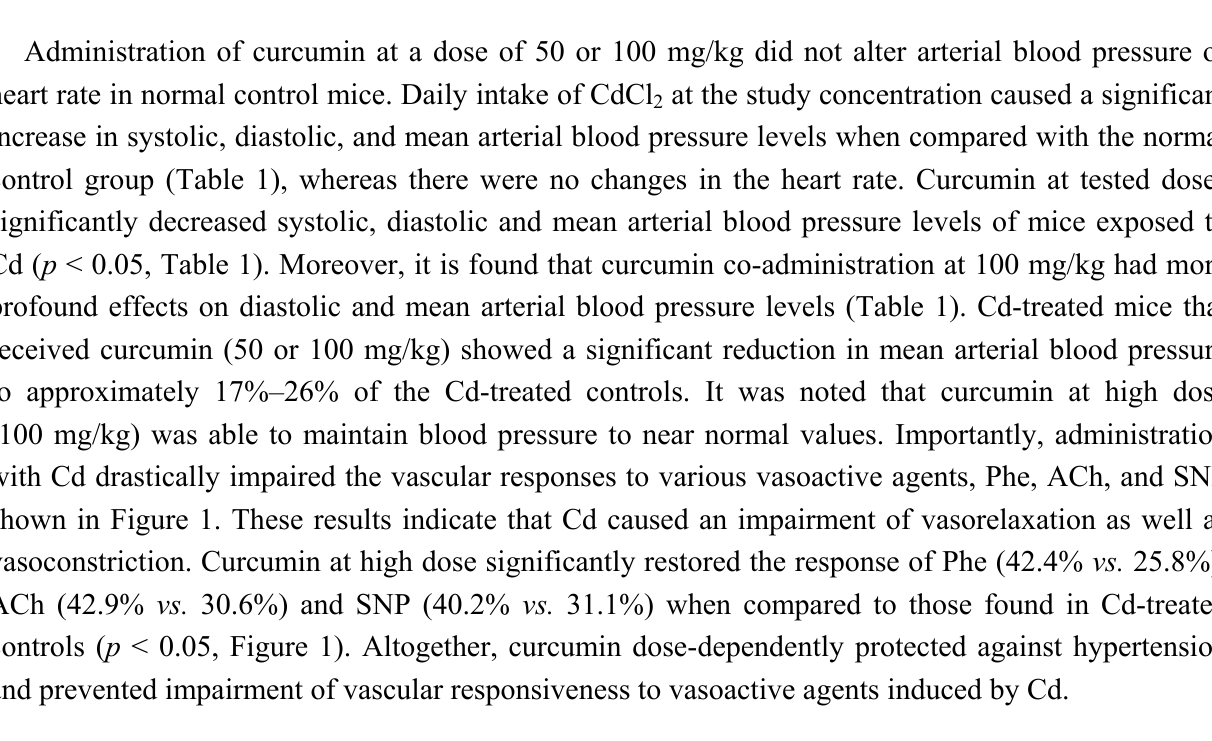
Table 1. Effects of curcumin co-administration on cadmium-induced changes in blood pressure levels and heart